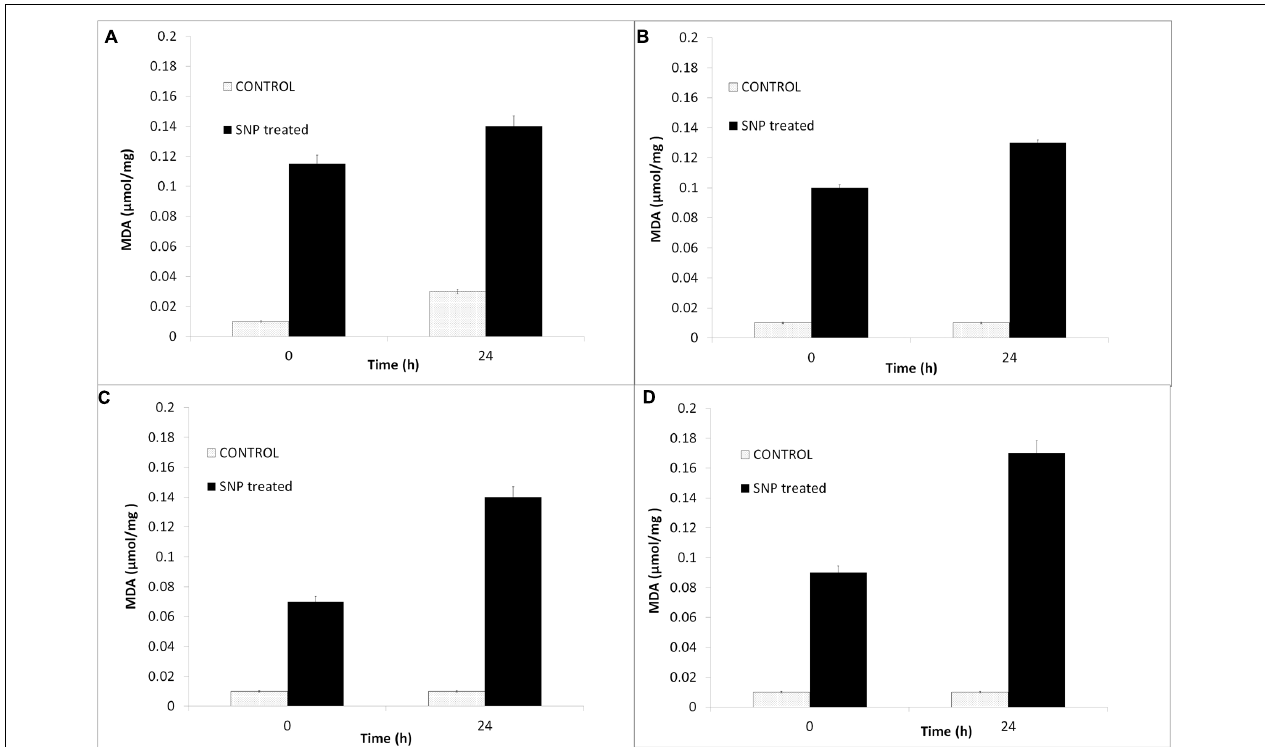
FIGURE 6 | Effect of SNPs on membrane lipid peroxidation as detected by MDA content in haloarchaea (A) Haloarcula argentinensis, (B) Haloarcula tradensis, (C) Haloferax lucentense , and (D) Haloferax prahovense. Error bar represents standard